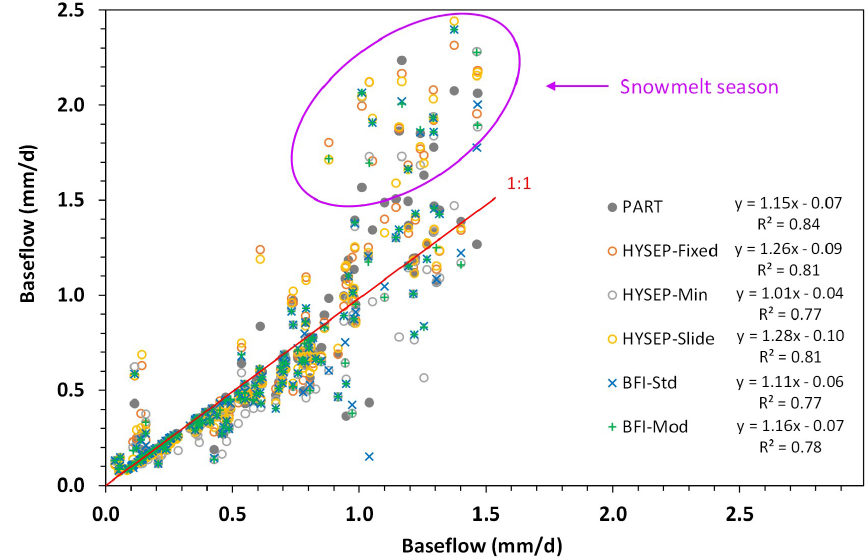
Figure 11. Comparisons of baseflow estimated from this study ( x axis) with those from PART, HYSEP (Fixed Interval, Sliding Interval, and Local Minimum), and BFI (Standard and Modified) ( y